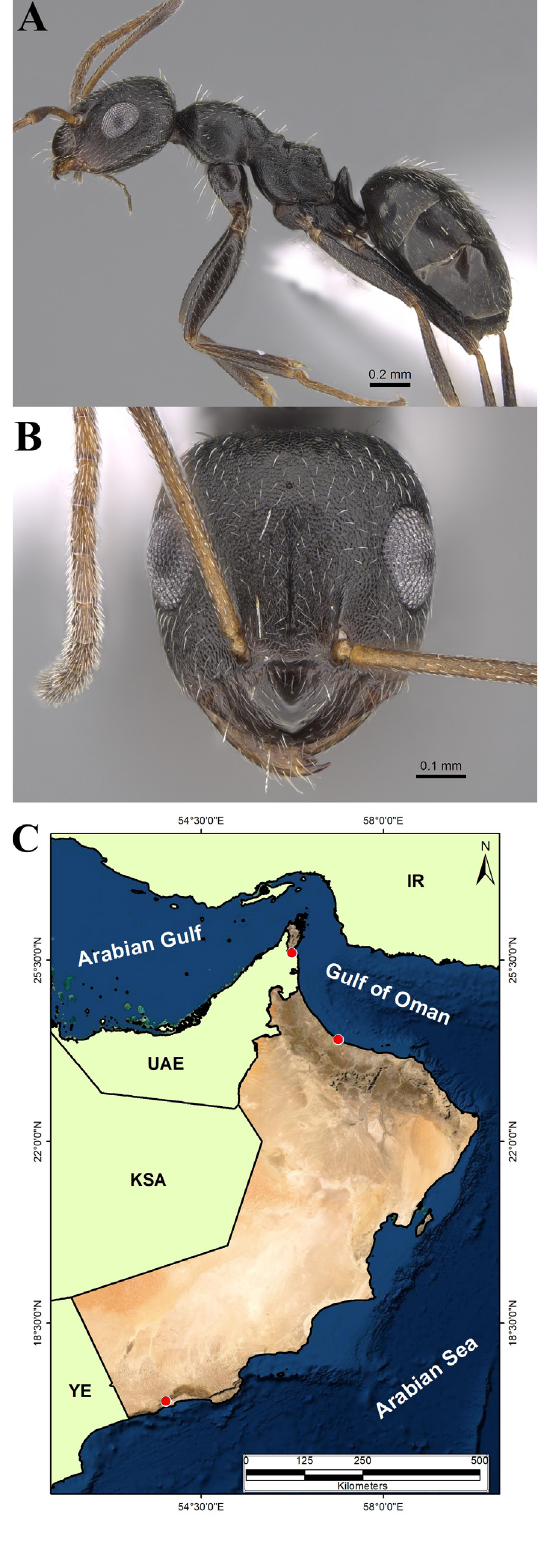
Fig. 19. Lepisiota obtusa (Emery, 1901), worker (CASENT0922844, AntWeb.org (Michele Esposito)). A . Body in profile. B . Head in full-face view. C . Distribution